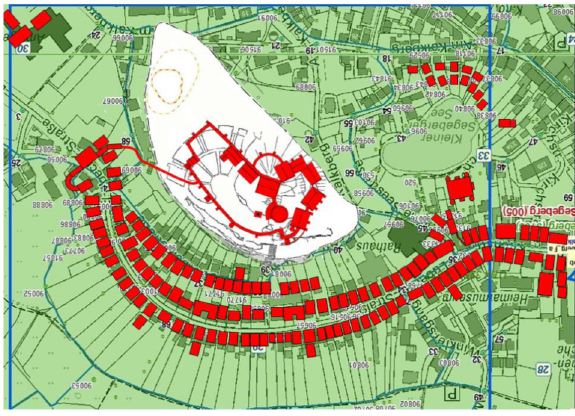
Figure 9. Map of the present city (green) with the state of 1600 as overlay (red)